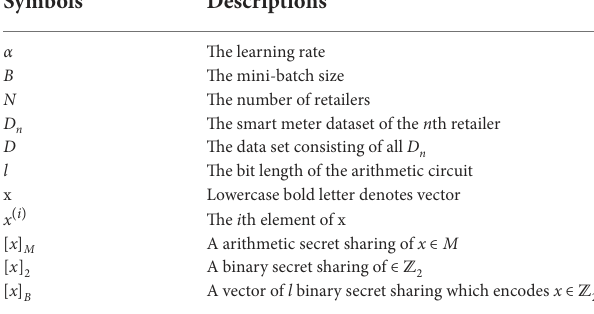
TABLE 1 Notations used in this